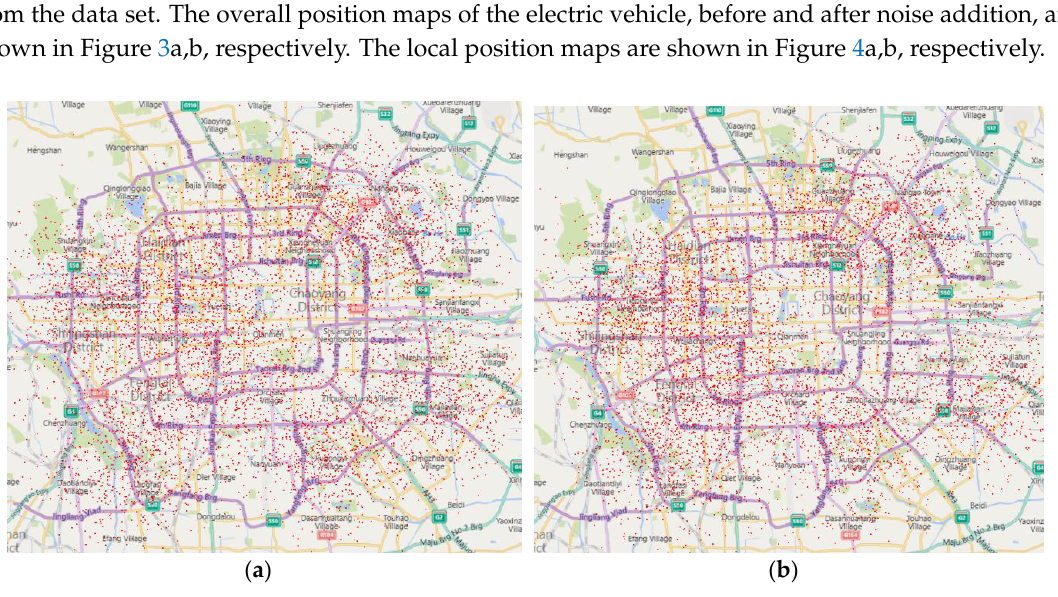
Figure 3. The overall position maps of EVs. ( a ) before noise addition; ( b ) after noise addition. Energies 2018 , 11 , x FOR PEER REVIEW